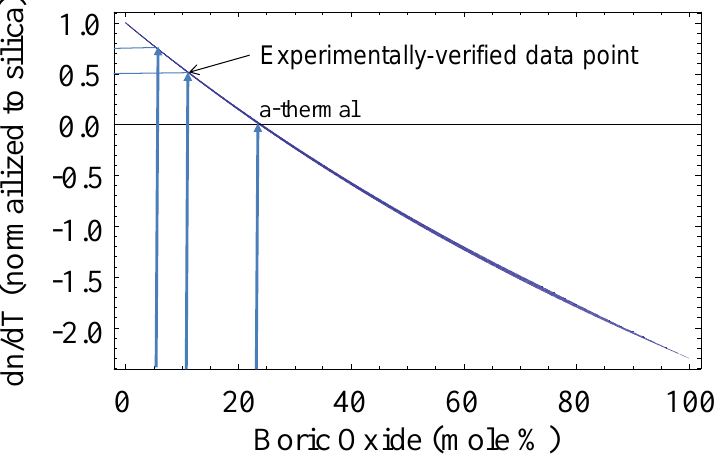
Figure 3. Thermo-optic coefficient of borosilicate glass with increasing boria content. A measured data point on a fabricated fiber is provided. The compositions where d n /d T reduces by 25% and becomes zero (athermal) are identified on the